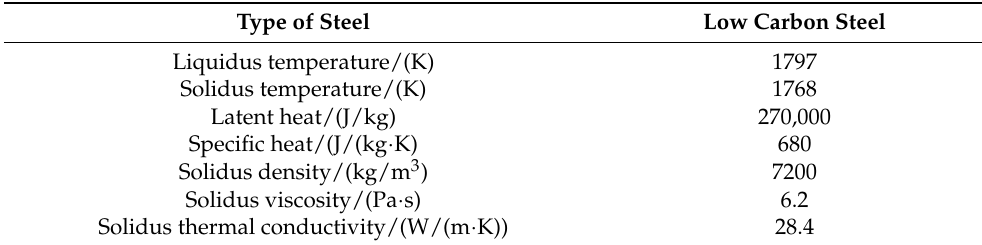
Figure 12. Schematic diagram of oxygen-natural gas flame cutting process. Table 1. Thermal physical properties of low carbon steel.